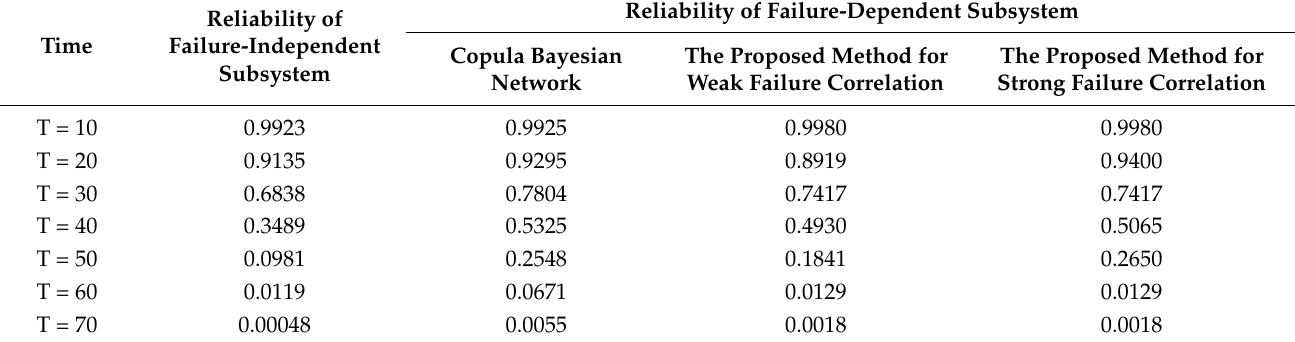
Table 12. Comparison of subsystem reliability of Machine pair